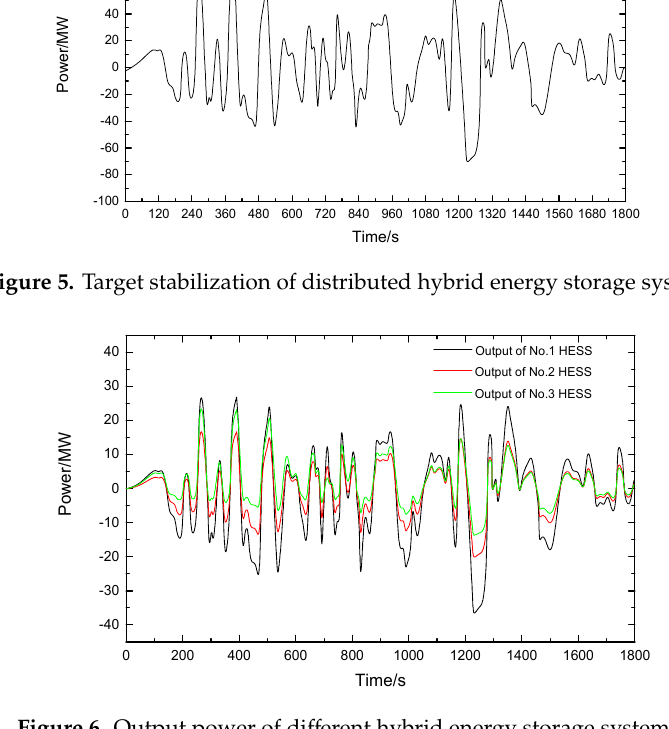
Figure 6. Output power of different hybrid energy storage systems.